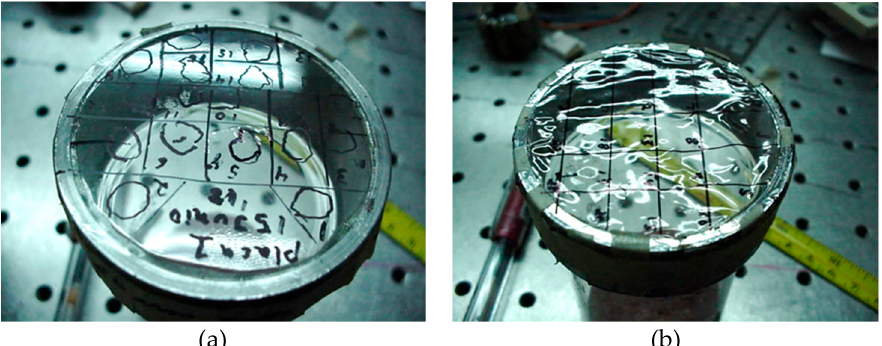
Figure 21. Normalized First order intensity, as a function of RH, for two gratings recorded in 15 µm and 50 µm thickness gelatin layers.